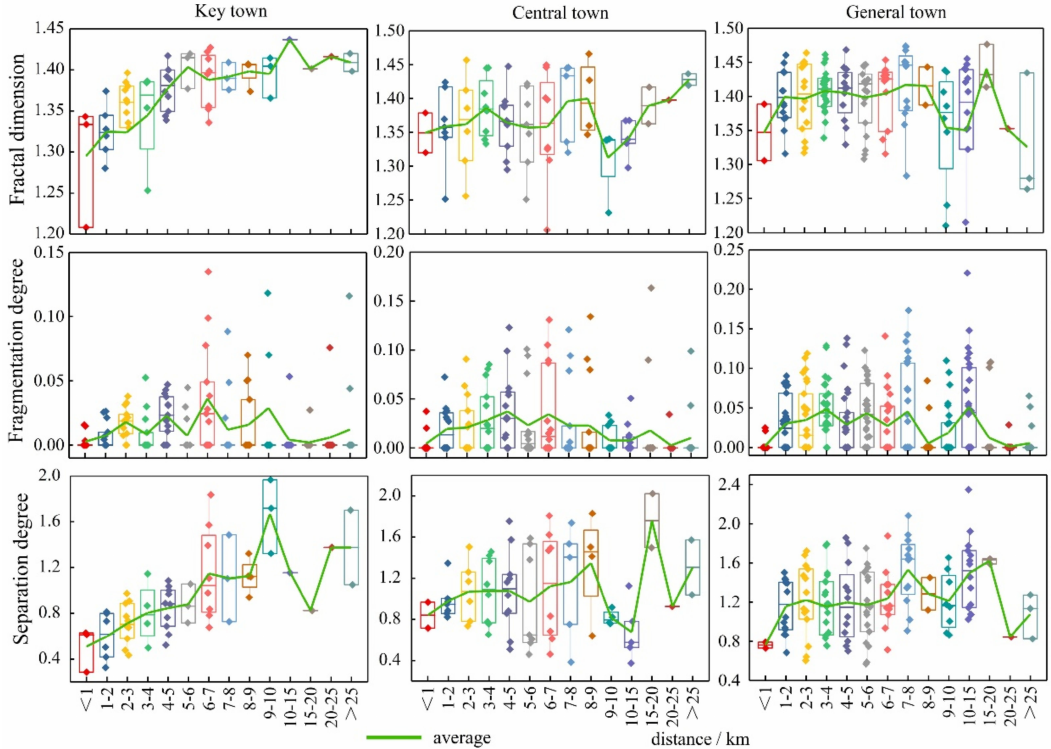
Figure 7. Township gradient differentiation of the spatial layout of rural construction